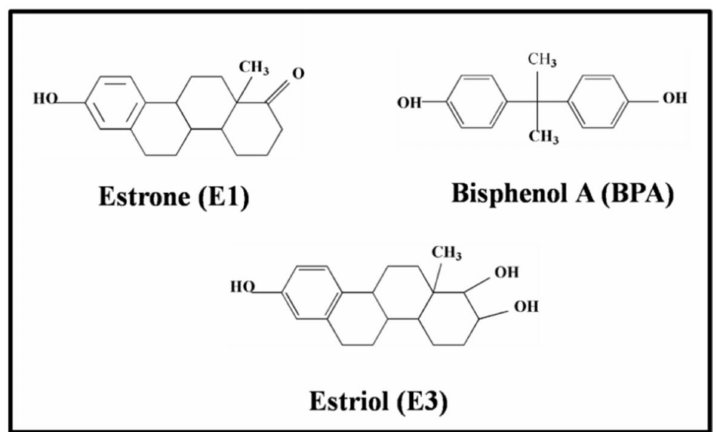
Figure 1. Molecular structures of two natural estrogens (estrone (E1), and estriol (E3)) and a synthetic estrogen (bisphenol A